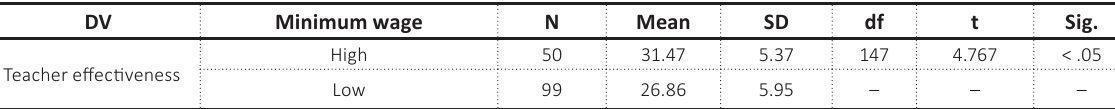
Table 2. T-test summary that shows the influence of payment of minimum wages on teacher